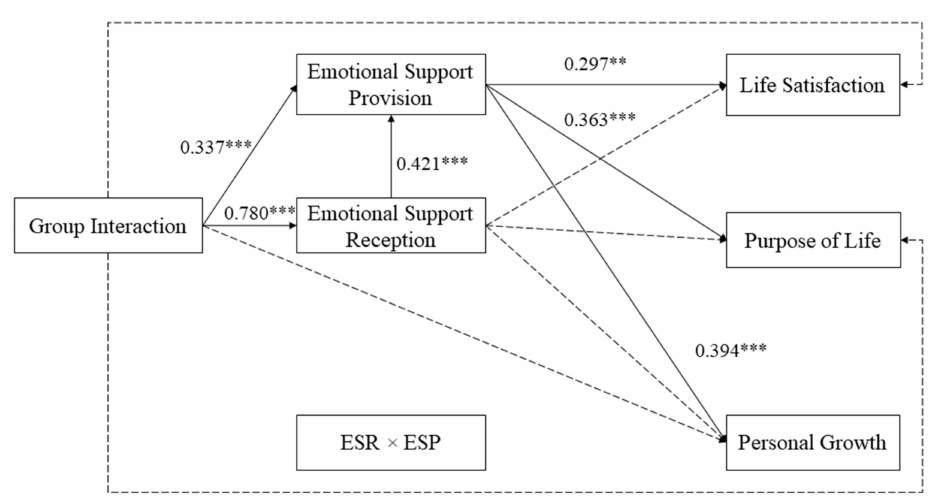
Figure 3. Standardized solutions for the sequential reciprocity model with the control for background and baseline psychological well-being variables. Full lines represent significant relationships. Dotted lines represent non-significant relationships. ESR × ESP = emotional support reception (baseline) × emotional support provision (follow-up). ** p < 0.01. *** p <